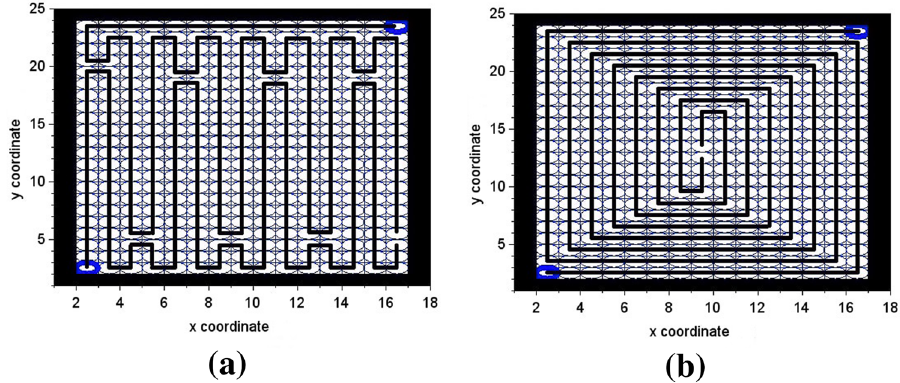
Fig. 9 a Mobile robots with no relative heading; b mobile robots with relative